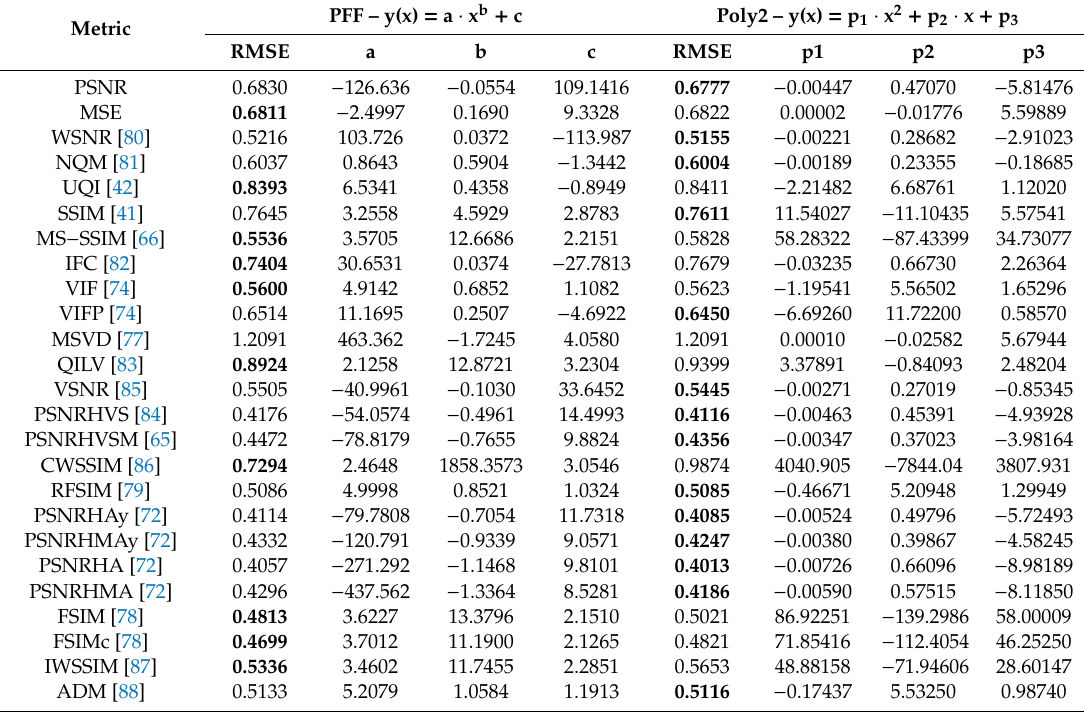
Table 3. Metric fitting results and parameters for the Power Fitting Function (PFF) and second order polynomial (Poly2); better RMSE values are shown in bold